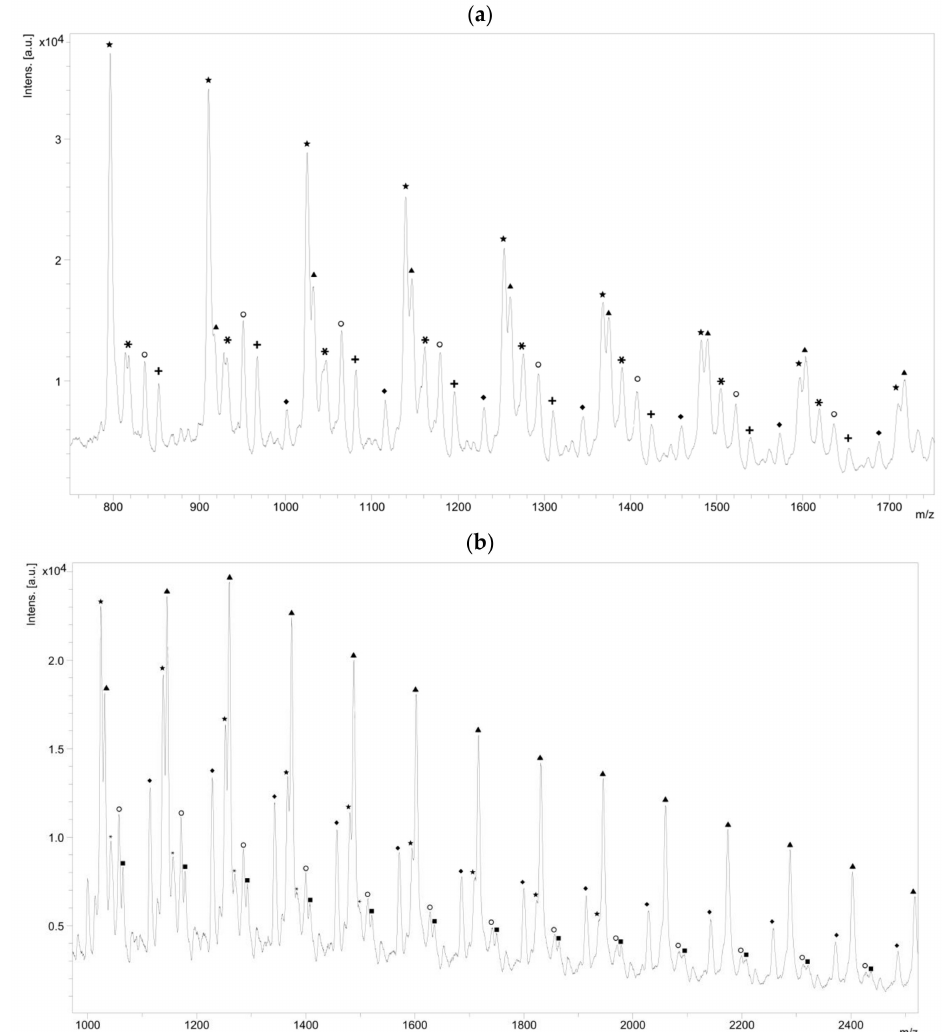
Figure 6. MALDI-ToF MS spectrum of polymerization product between CL and: ( a ) 2 mol %; and ( b ) 10 mol % of N -Boc Cys